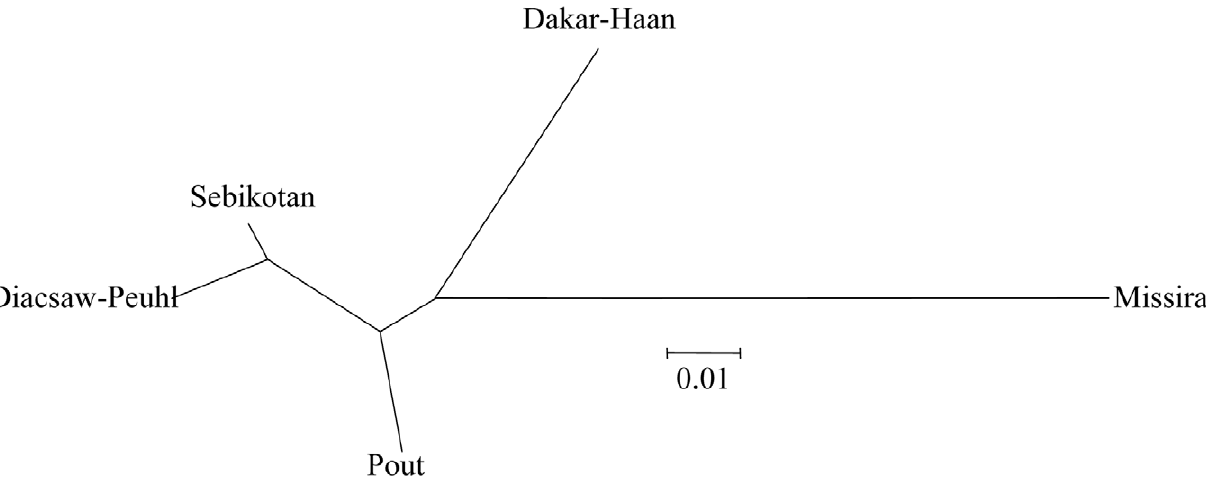
Figure 3. Unrooted Cavalli-Sforza and Edward’s chord distance based Neighbour-Joining-Tree. This tree shows the respective genetic distribution of the five G. palpalis gambiensis tsetse samples from Senegal.